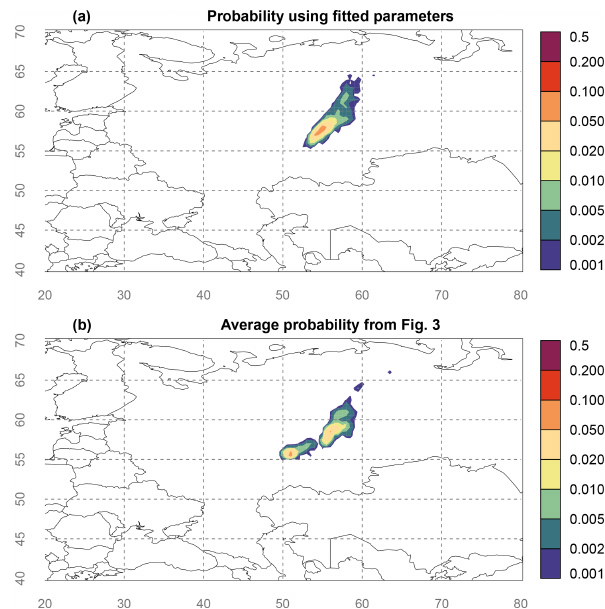
Figure 7. Source location probability map obtained from the Bayesian source reconstruction. (a) The parameters of the inverse gamma distribution were obtained using the ensemble SRS for each observation separately. (b) The average source location probability is taken from all six panels shown in Fig. 3. The longitude and lati- tude are shown by grey numbers and dashed